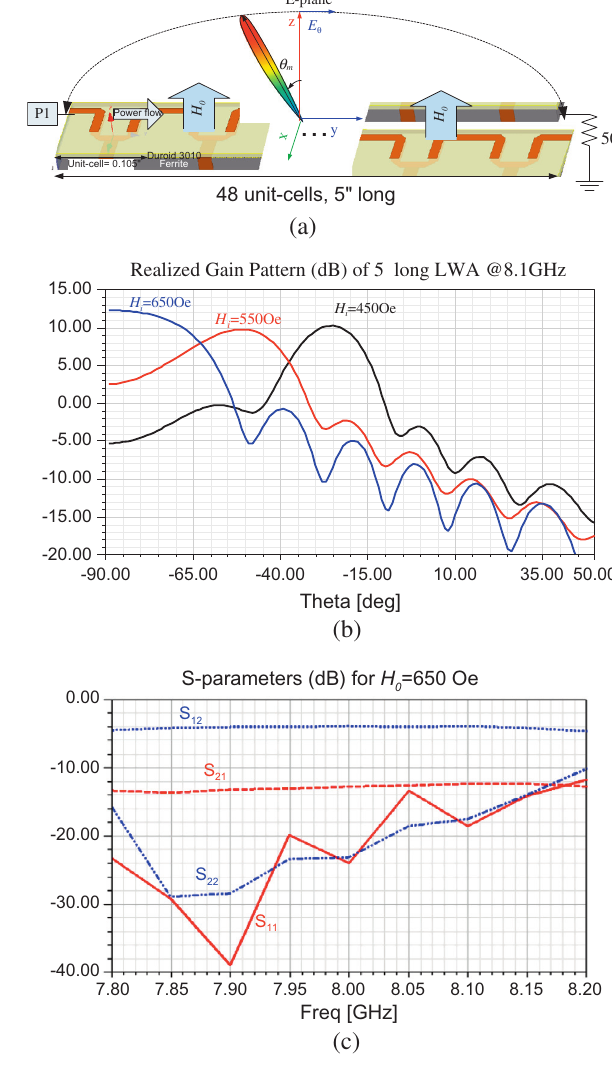
Figure 14. (a) Visualization of the LWA comprised of 48 unit-cells, fed at port 1 and terminated with 50 X at the unused port. (b) Beamscanning performance of the proposed LWA at 8.1 GHz by changing the bias field ±100 Oe. (c) S -parameters for the given ferrite CRLH layout between 7.8 GHz and 8.2 GHz. note that S 11 is less than (cid:2) 10 dB over the bandwidth.